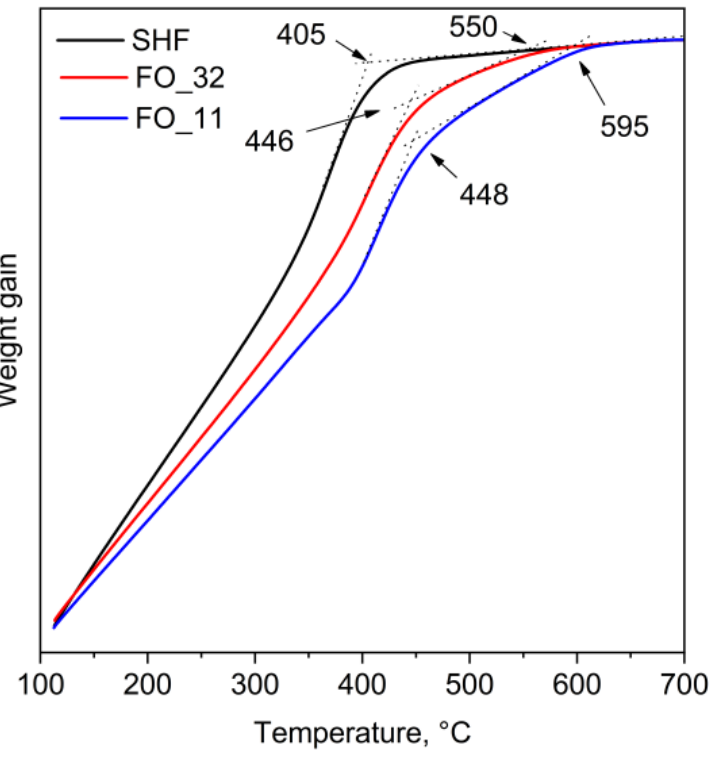
Figure 6. Thermogravimetry curves for raw SrFe 10 Cr 2 O 19 (SHF) and composite samples (FO) mea- sured in an applied magnetic field. Table 2. Curie temperatures of the samples measured by thermogravimetry in a magnetic field.